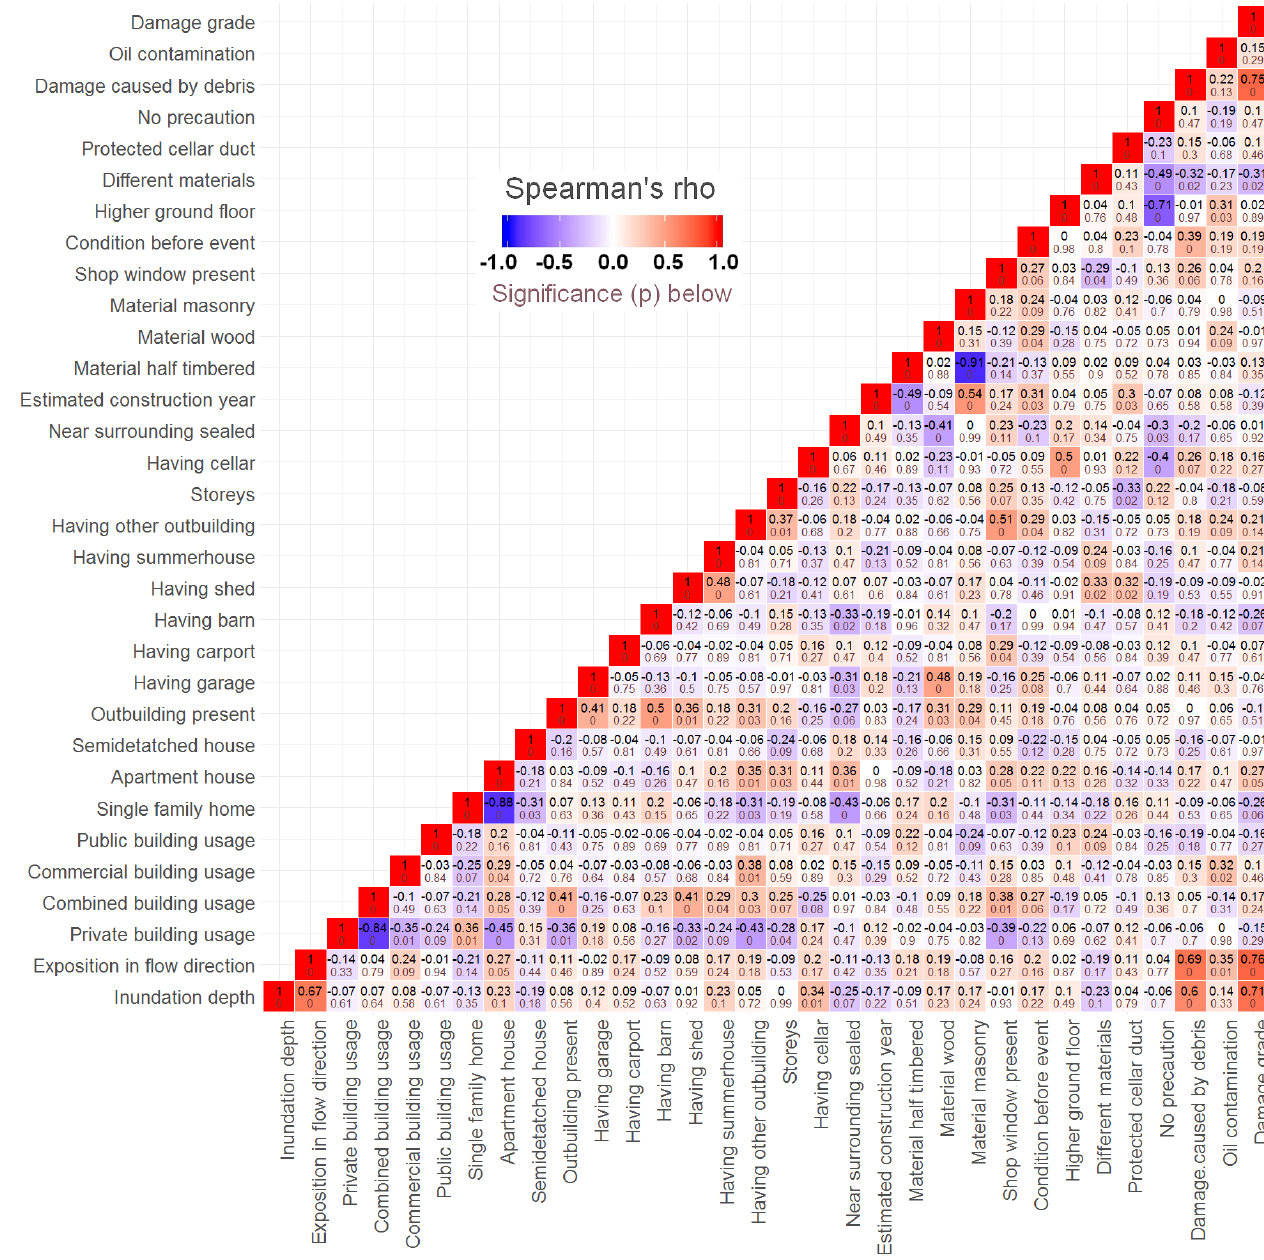
Figure A1. Spearman’s rank correlation matrix and correlation significance of all variables in the data set. The count of complete cases for the analysis was